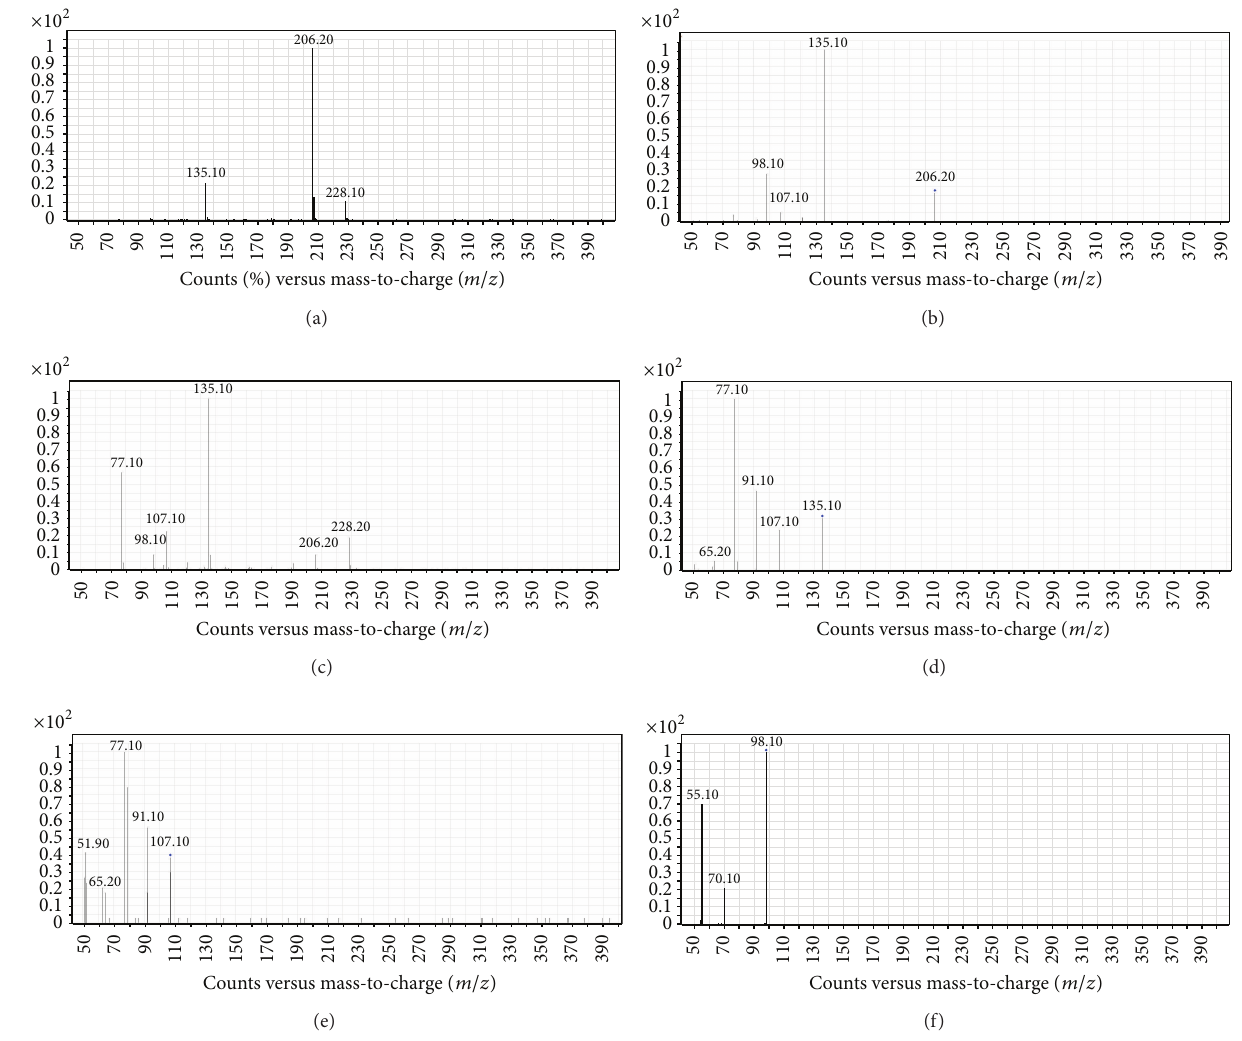
Figure 3: (a) ESI mass spectrum of compound 4c [M + H] + ion ( m/z 206.20). (b) MS 2 spectrum of m/z 206.20. (c) In-source fragmentation of compound 4c . (d) MS 2 spectrum of m/z 135.10. (e) MS 2 spectrum of m/z 107.10. (f) MS 2 spectrum of m/z 98.10.